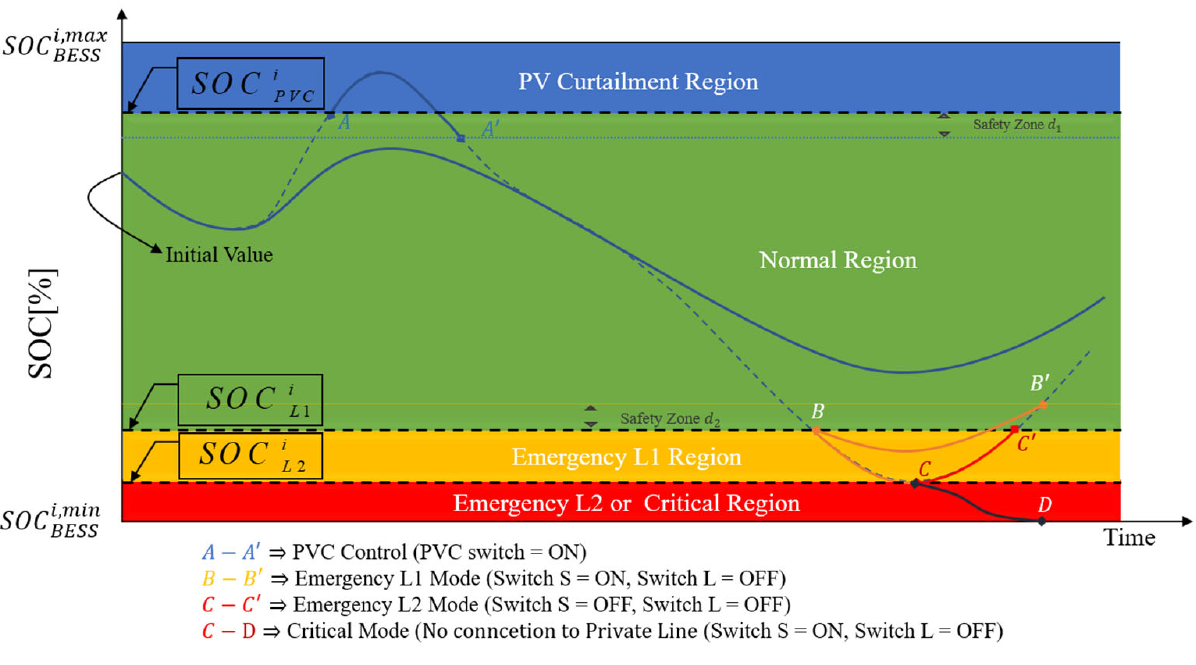
Figure 5. Definition of the BESS SOC operating region.